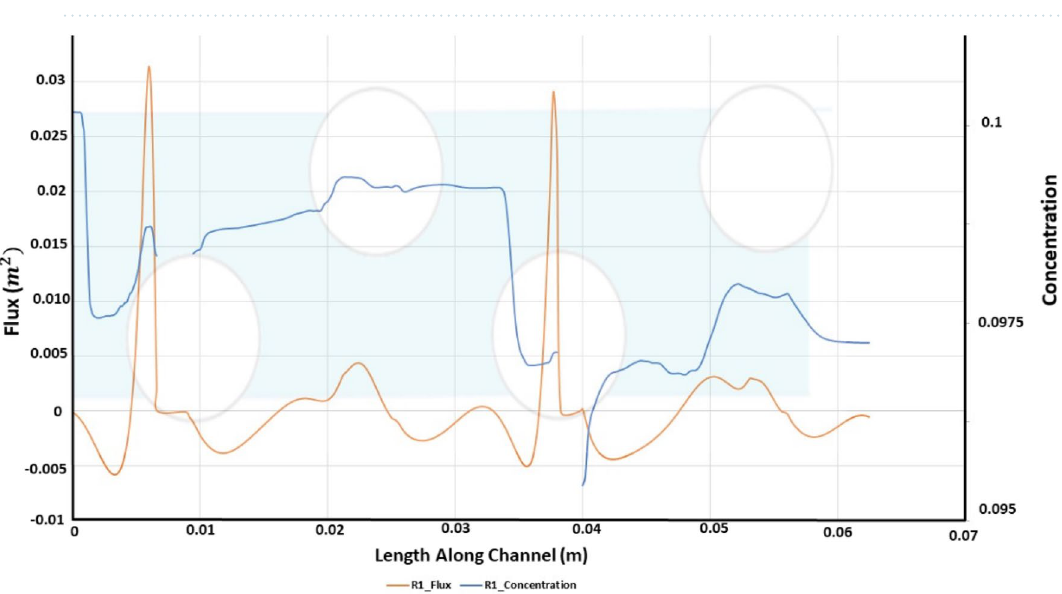
Figure 9. Length along channel vs flux and concentration for